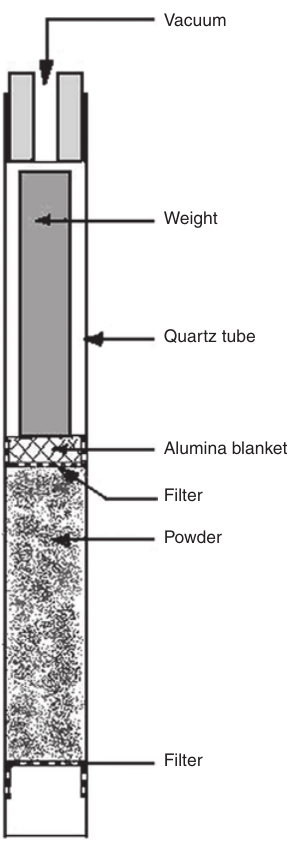
Figure 1: Infiltraation tube.